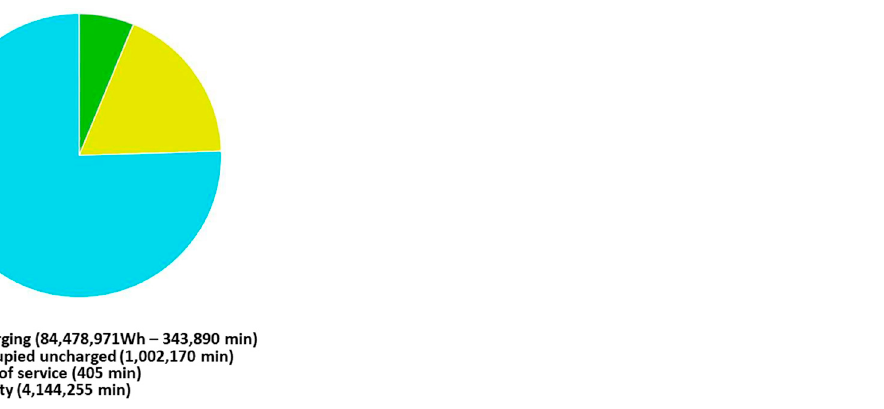
Figure 12. The usage of EV charging station on Fabricii street from January 2019 to June 2022.